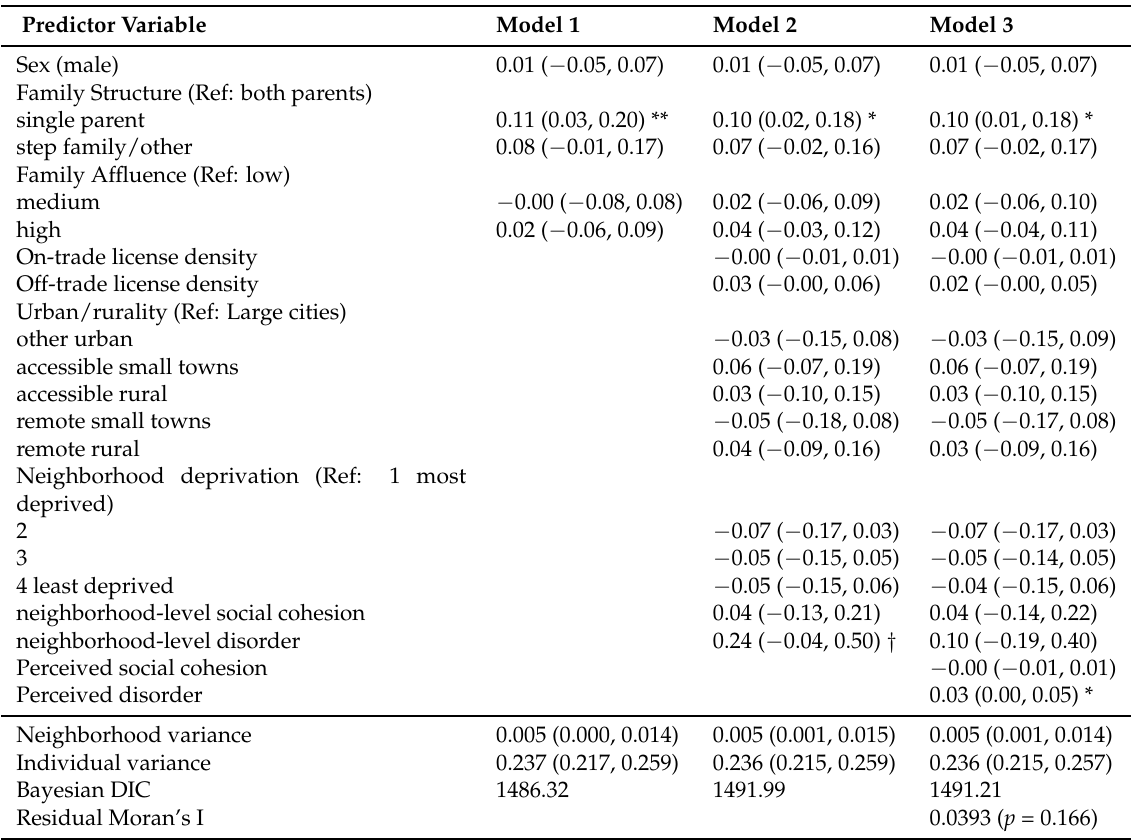
Table A3. Enhancement motives regressed on neighborhood and individual measures (95% credible intervals) n = 1045 (Intermediate Data Zones n = 188).